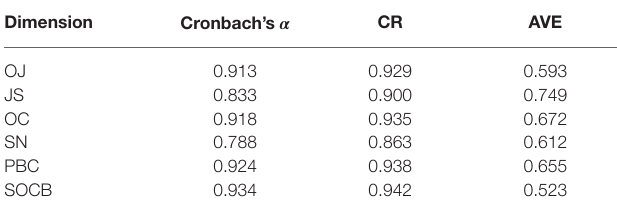
TABLE 3 | Reliability and convergent